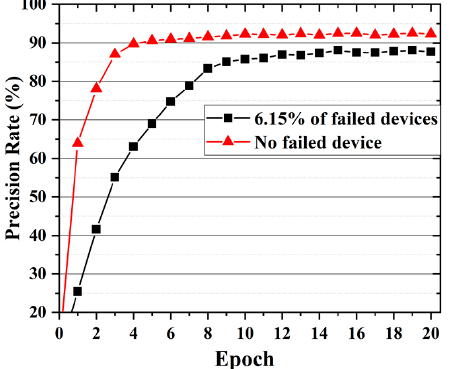
Figure 5. The image recognition accuracy rate of the single-layer network varies with the number of cyclic trainings.